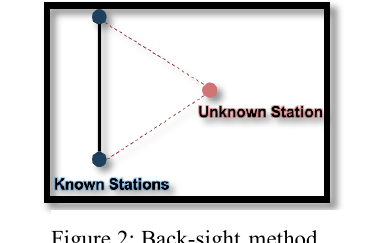
Figure 2: Back-sight method.